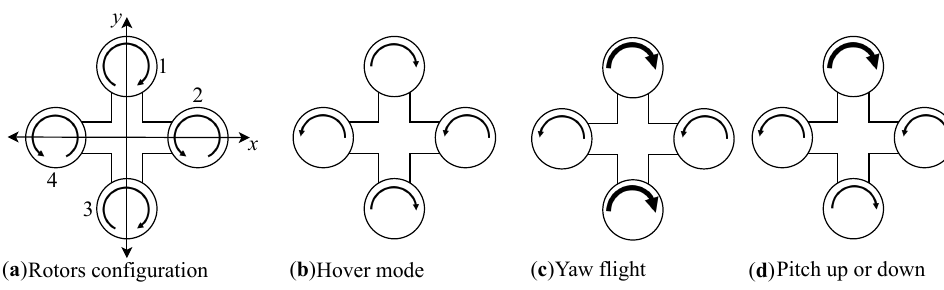
Figure 1. Configuration of rotors in